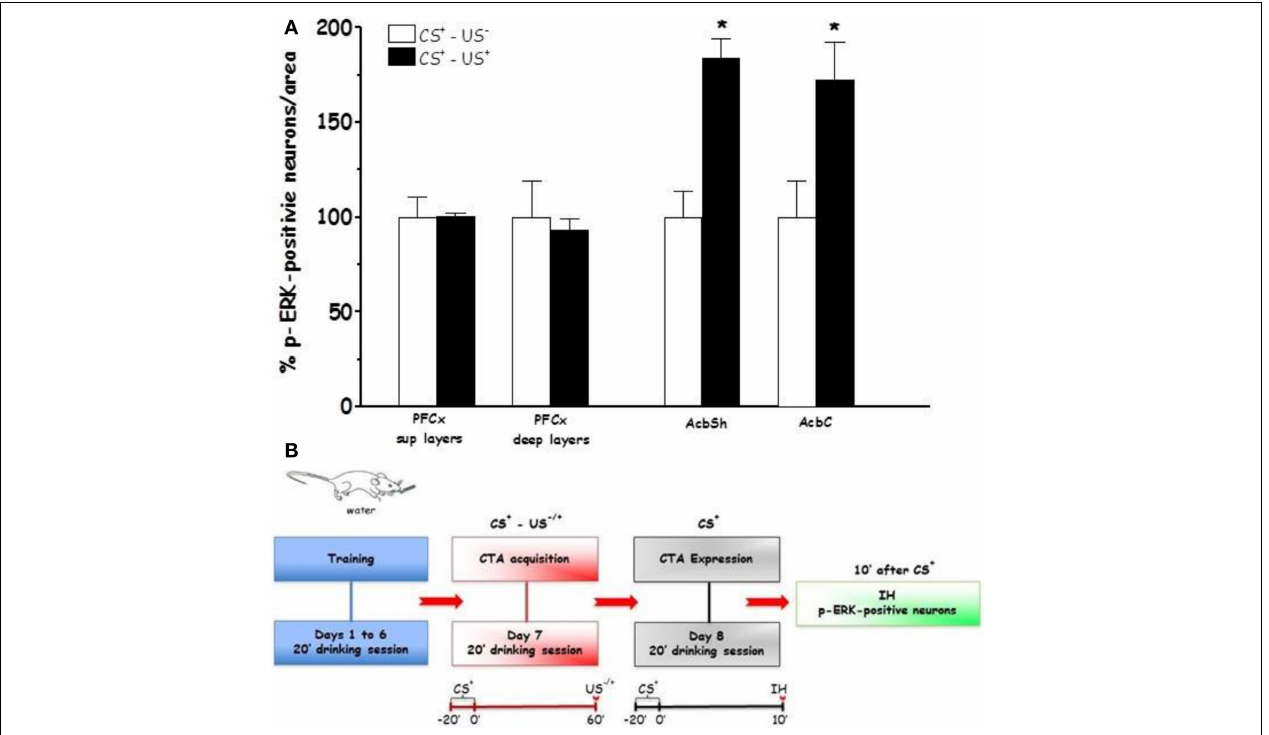
FIGURE 4 | Expression (Expr1) (A): Effect of CTA expression on % changes of p-ERK-positive neurons/area in the PFCx (superficial and deep layers) and Acb (shell and core). Data, average + s.e.m., are expressed as % changes with respect to the effect in control group (CS + -US − ) set as 100%. Lithium chloride (LiCl, 125mg/kg i.p., US + ) or saline (i.p., US − ) were administered on